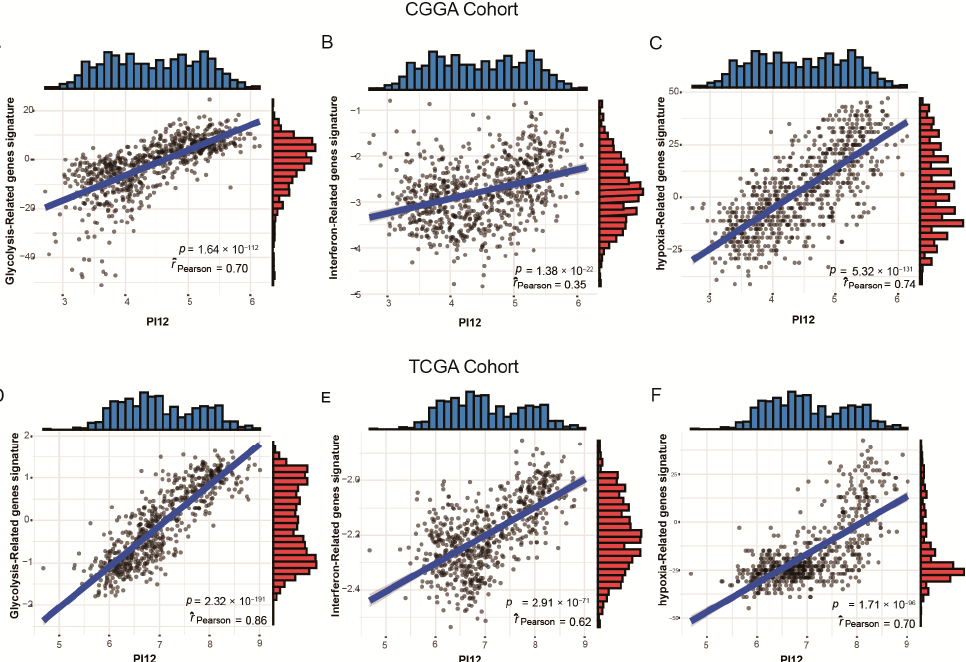
Figure 12. Relationship between PI12 score and validated biological process signatures. ( A , D ) Correlation between PI12 score and glycolysis − related genes signatures; ( B , E ) Correlation between PI12 score and interferon-related gene signatures; ( C , F ) Correlation between PI12 score and interferon-related gene signatures.